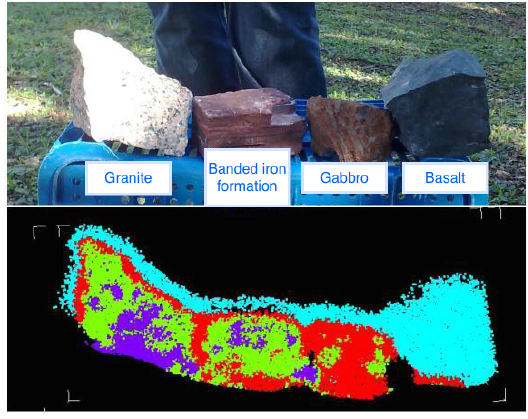
Figure 2: In the upper part four blocks scanned for the second experiments are shown. In the lower part, the effect of clustering intensity data is